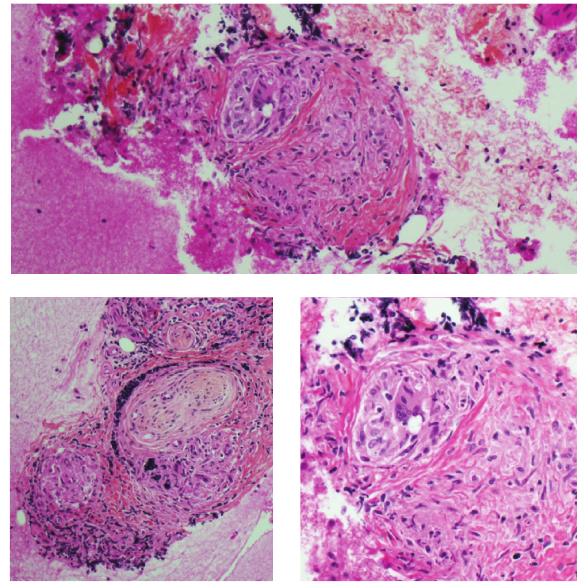
Figure 4: Histology from fine-needle aspiration showing nonnecro- tizing granulomatous